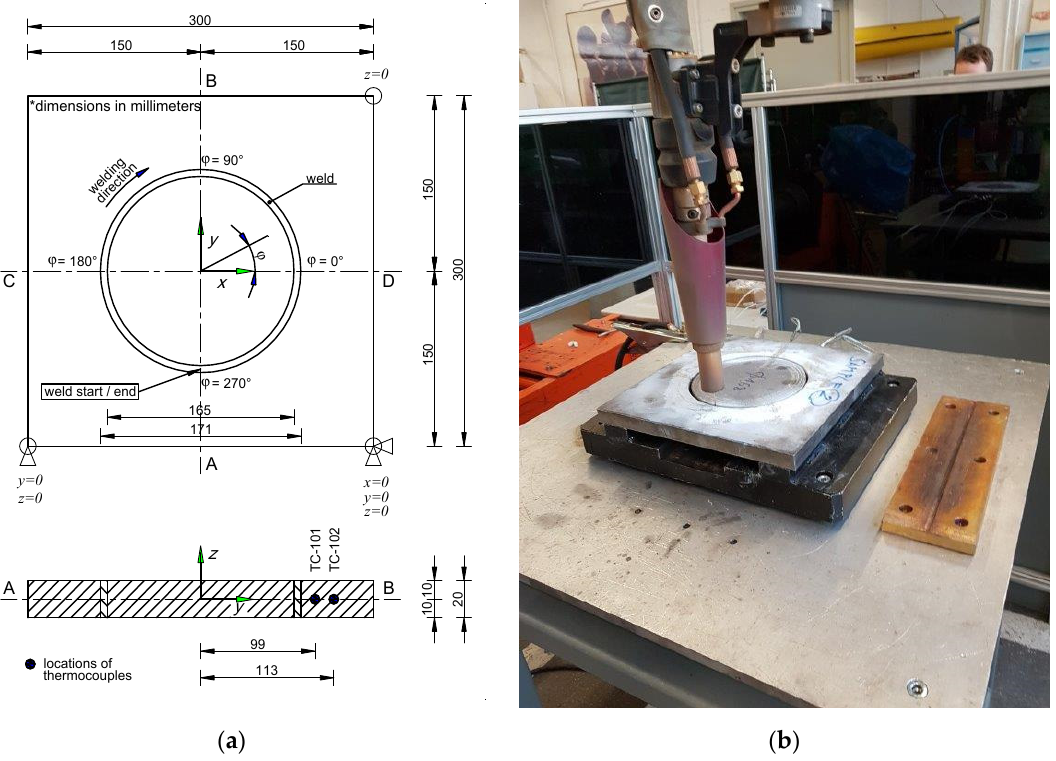
Figure 1. Buried-arc-welded circular disk: ( a ) Geometry and dimensions; ( b ) Experimental setup.